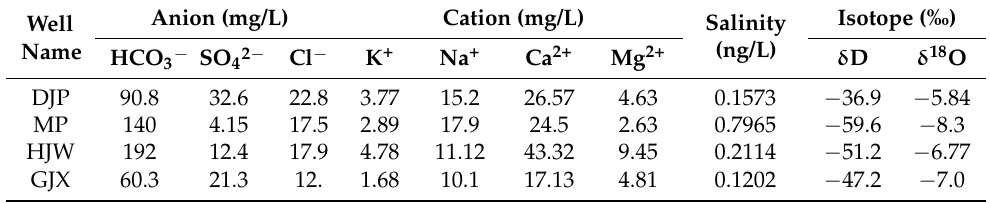
Table 2. Water chemistry and isotope measurement results in the studied four wells.